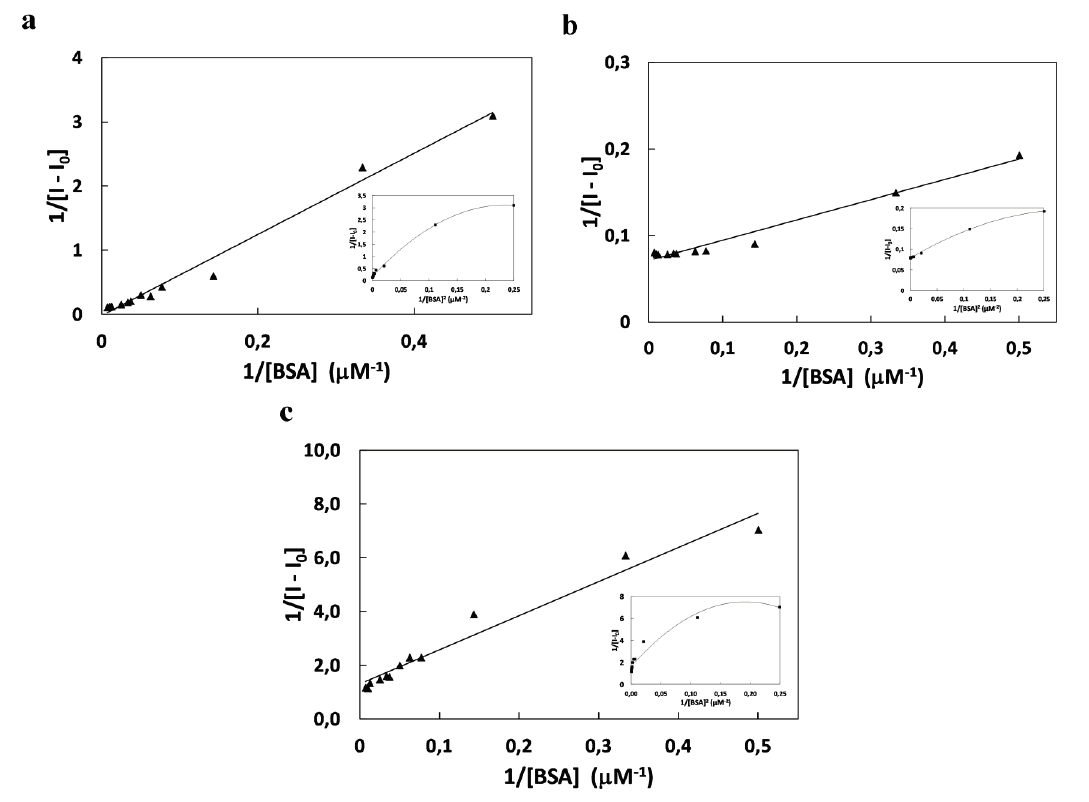
Figure 2. Benesi − Hildebrandt plot of 1/ I − I 0 vs. 1/[BSA] for binding of SQ6 ( a ); SQ7 ( b ); SQ8 ( c ) with inserted correlation 1/ I − I 0 with 1/[BSA] 2 for binding process of squarine dyes with BSA.